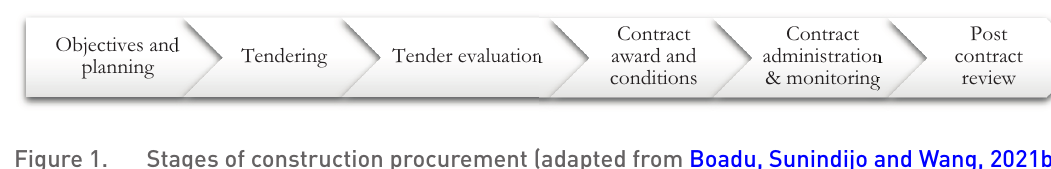
Figure 1. Stages of construction procurement (adapted from Boadu, Sunindijo and Wang,